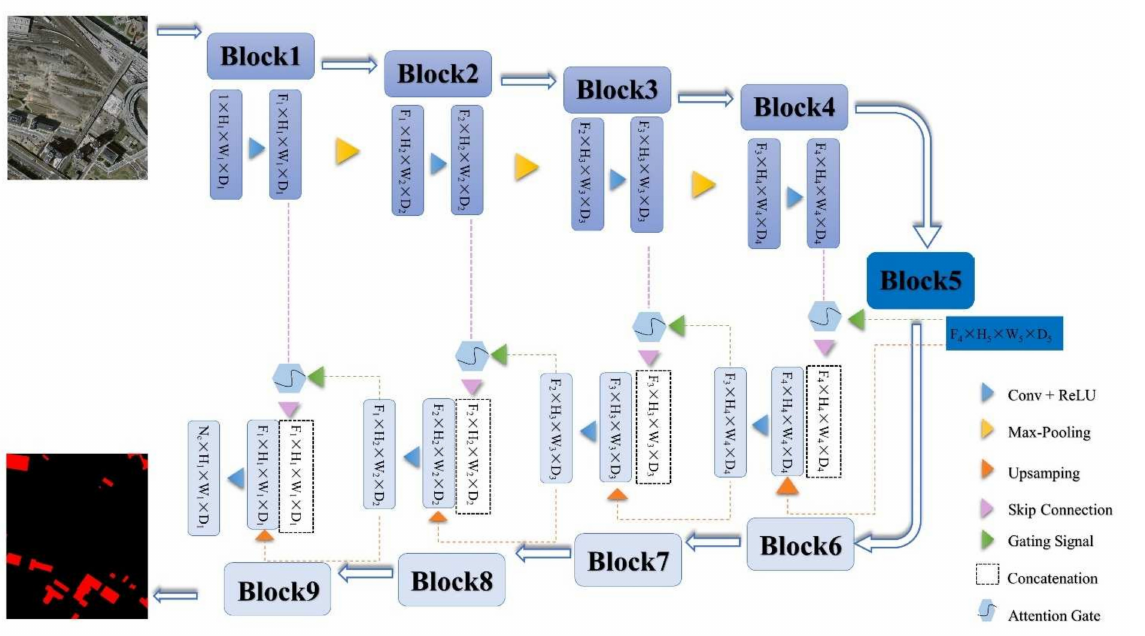
Figure 1. Model framework of AGs-Unet, consisting of three parts: encoder part (blue, block 1–4), the converter (navy blue and pink, block 5 and ‘skip connection’), and decoder (blocks